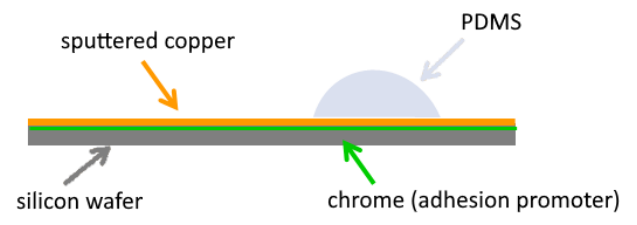
Figure 2. Specimen layout. A silicon wafer (with chrome as optional adhesion promoter) is coated with copper via PVD. On this copper surface (further pre-treatment possible), drops of Sylgard-184 are placed and